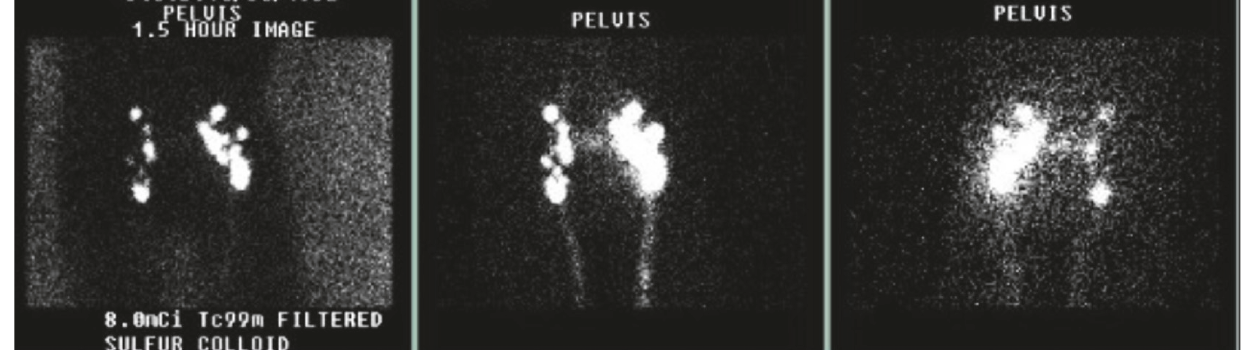
Figure 3: Lymphocytic scintigraphy results of the pelvic area showing no activity beyond the pelvis.